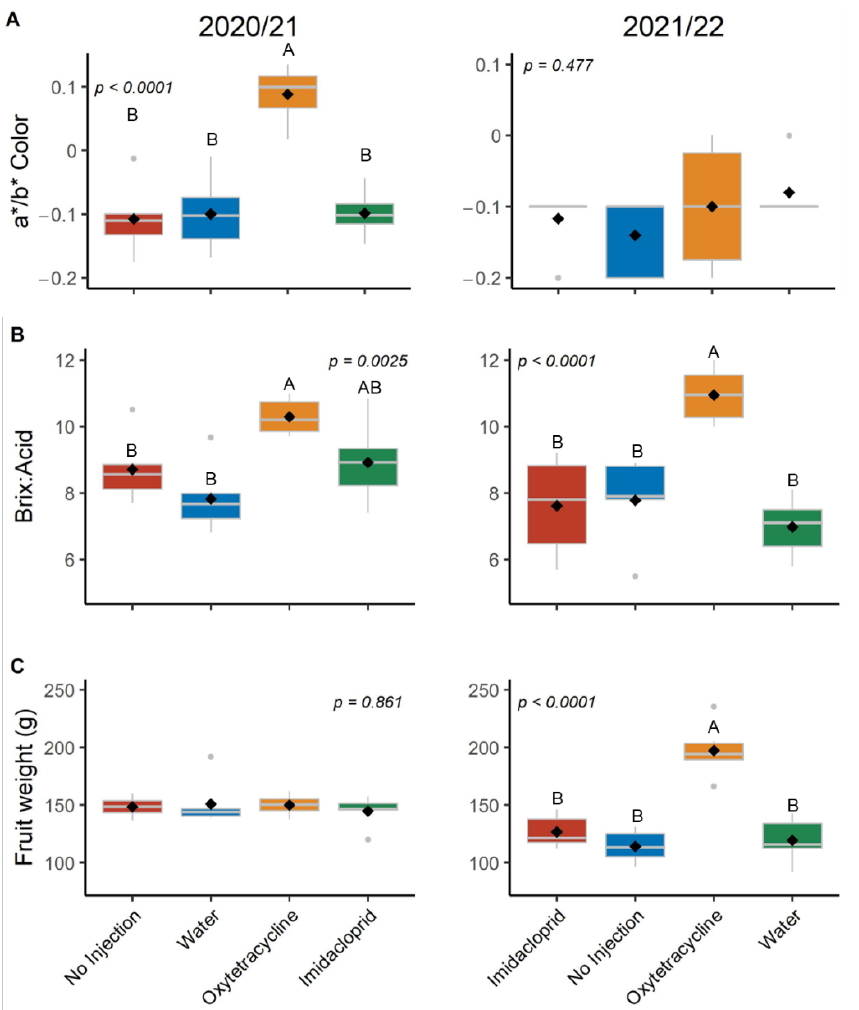
Figure 4. Fruit quality at harvest in production seasons 2020/21 and 2021/22. ( A ) External rind a*/b* color ratio; ( B ) ratio of percent brix to titratable acidity; ( C ) fruit weight (grams per fruit). Different letters indicate significant differences ( p < 0.05) according to Tukey’s honest significant difference test. Letters not shown when differences were not significant.